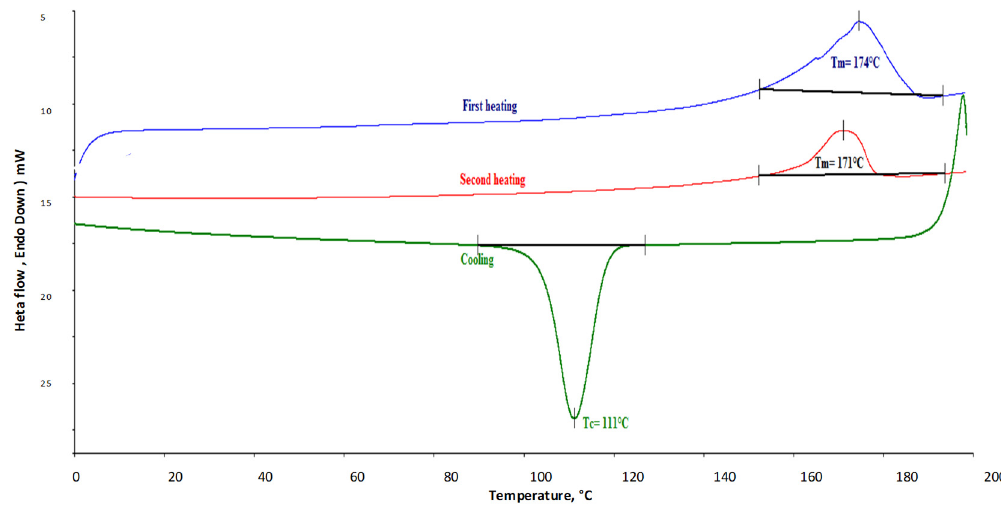
Figure 2. DSC thermogram of